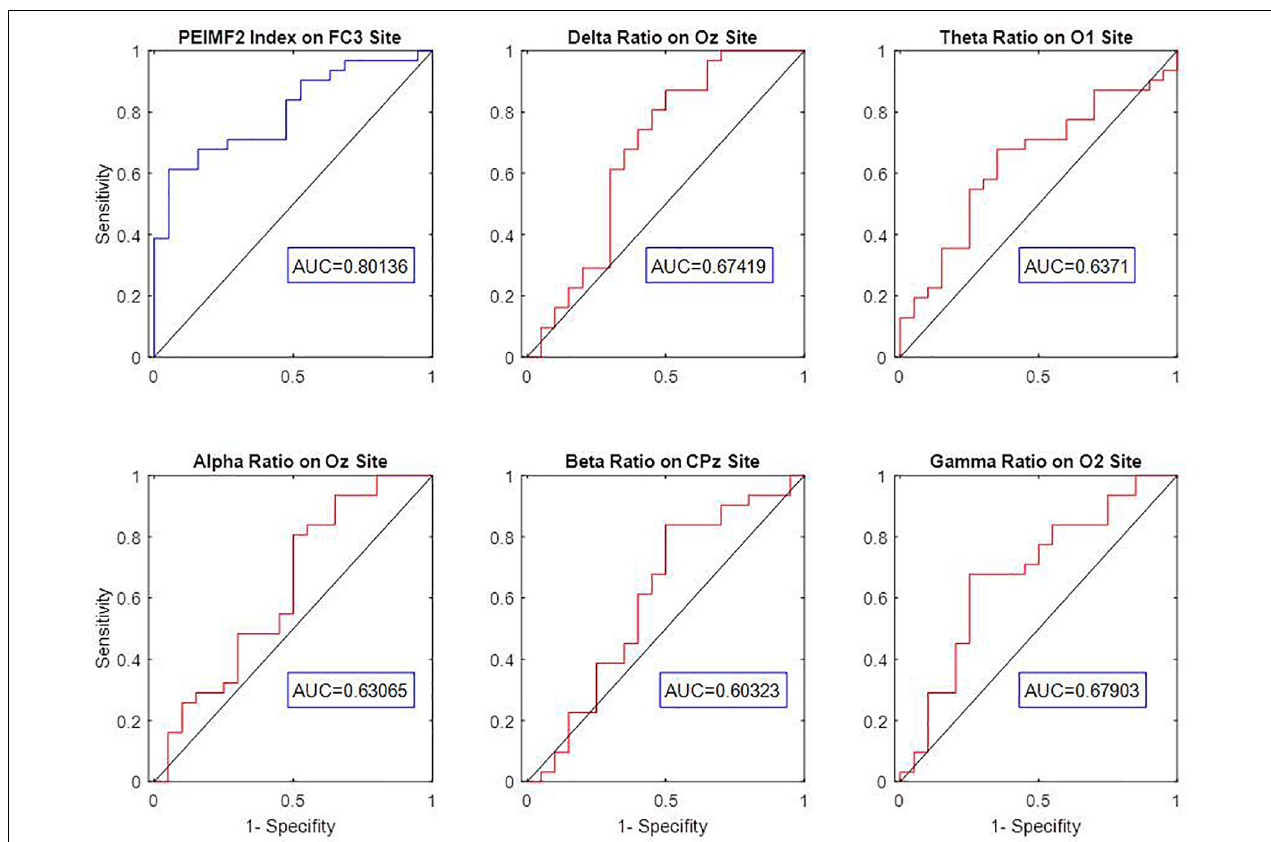
FIGURE 4 | ROC curve analysis and AUC value of Delta, Theta, Alpha, Beta, Gamma relative powers to discriminate between RP an NR on best electrodes. The low AUC value of frequency band measures indicates weak prediction accuracy of these linear approaches.